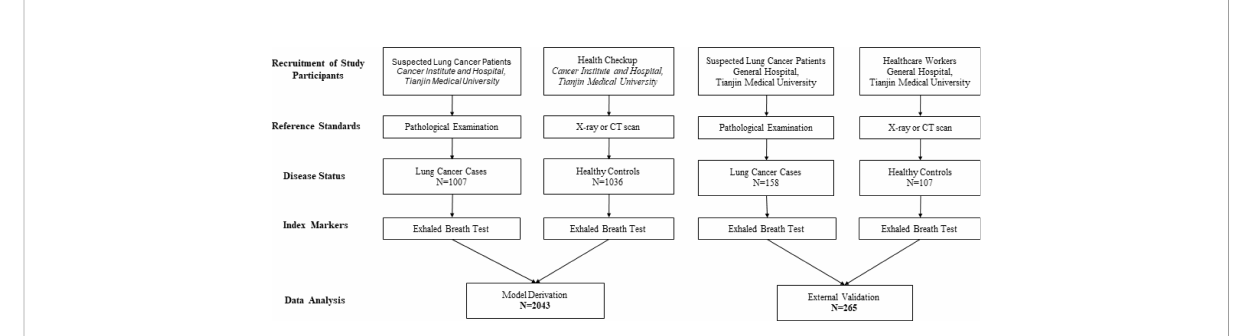
FIGURE 1 Flow chart for patient recruitment in model development and validation